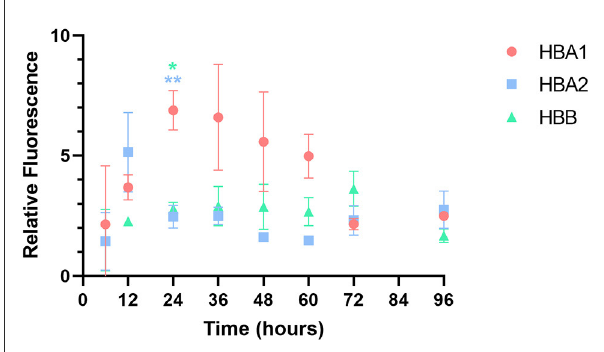
FIGURE3 Relative fluorescence of each GFP mRNA over time. Among the three GFP mRNAs, HBA1-GFP mRNA showed the highest fluorescence level 24h after transfection. Results are shown as the mean ± standard deviation. * P < 0.05, ** P < 0.01 vs. HBA2 and HBB at the same time point. ( HBA1 : GFP mRNA with UTR of canine hemoglobin subunit alpha-like 1; HBA2 : GFP mRNA with UTR of canine hemoglobin subunit alpha-like 2; HBB : GFP mRNA with UTR of canine hemoglobin subunit beta-like).